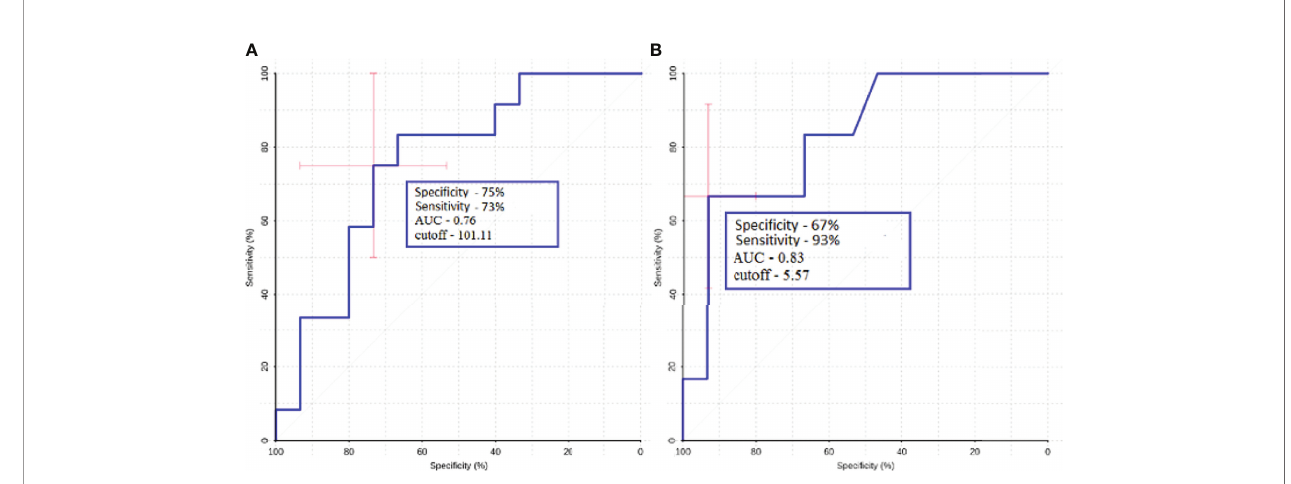
FIGURE 10 | ROC-analysis data obtained when comparing the maximum absolute (A) and normalized (B) values of intratumoral blood fl ow in the groups of metastatic lesions in lung cancer and